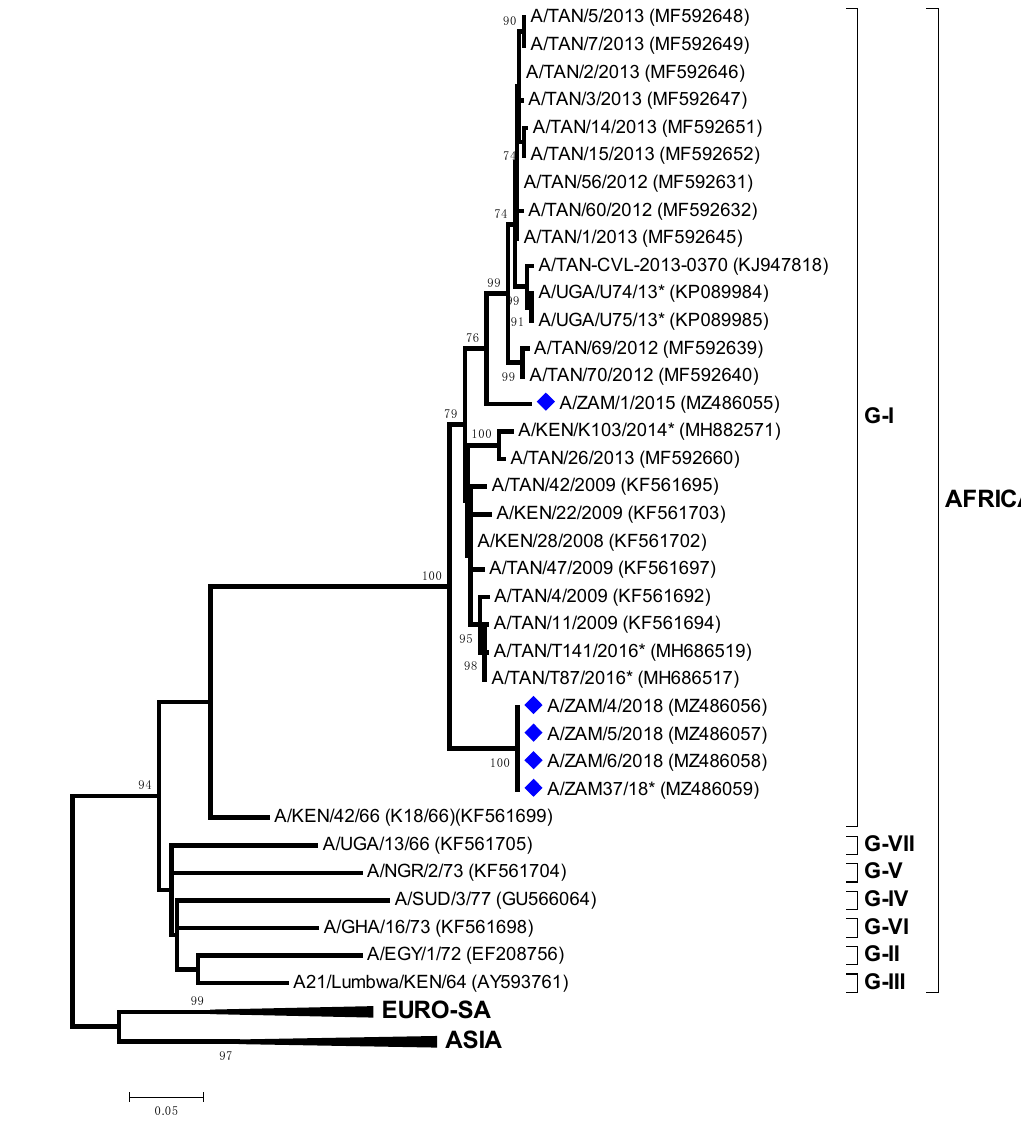
Figure 6. Midpoint-rooted maximum likelihood tree showing the relationships between the VP1 sequences of the 2015 and 2018 foot-and-mouth disease virus serotype A serotypes from Zambia (indicated with diamonds) and other contemporary and reference viruses. * Reference number not assigned by the WRLFMD.